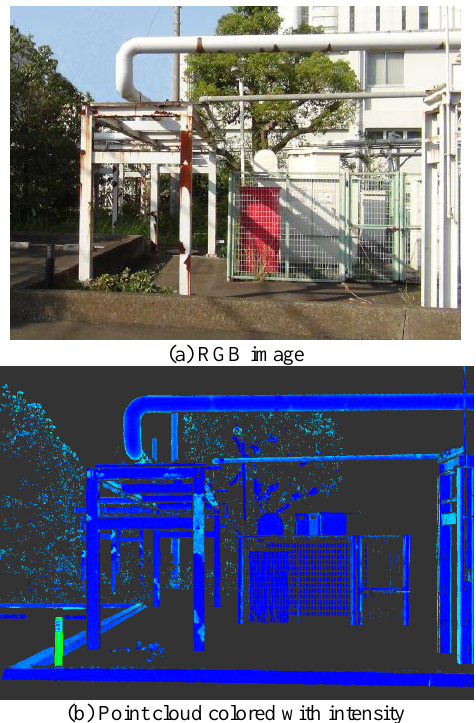
Figure 7. (a) RGB and (b) intensity image of test target. Both images were captured in daytime.